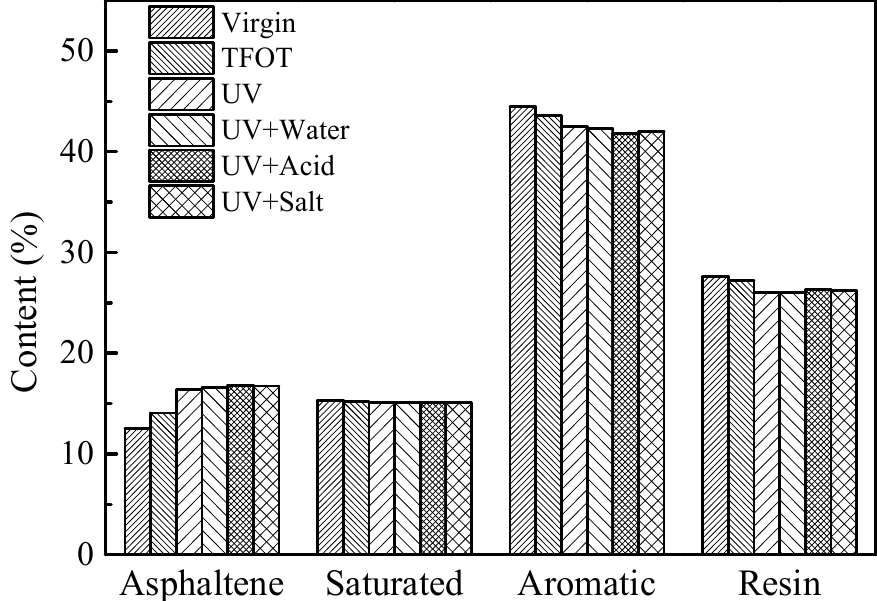
Figure 5. Contents of four components of SBS modified bitumen before and after UV aging in different environments.